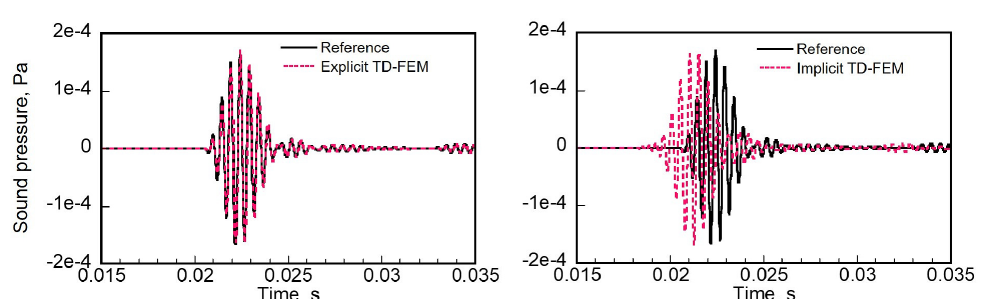
Figure 13. Comparisons of direct sound waveform at R1: the reference solution vs. the proposed explicit TD-FEM (Left) and the reference solution vs. the standard implicit TD-FEM